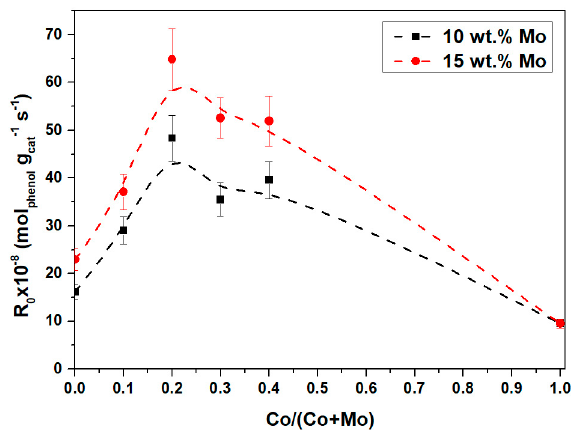
Figure 6. Initial reaction rates of HDO of phenol at different Co/(Co + Mo) ratios in the promoted CoMo/AT2 catalyst ( ■ ) at 10 wt.% Mo and ( ● ) 15 wt.% Mo.